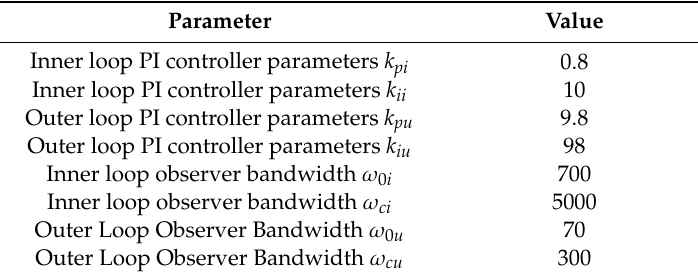
Table A2. Controller